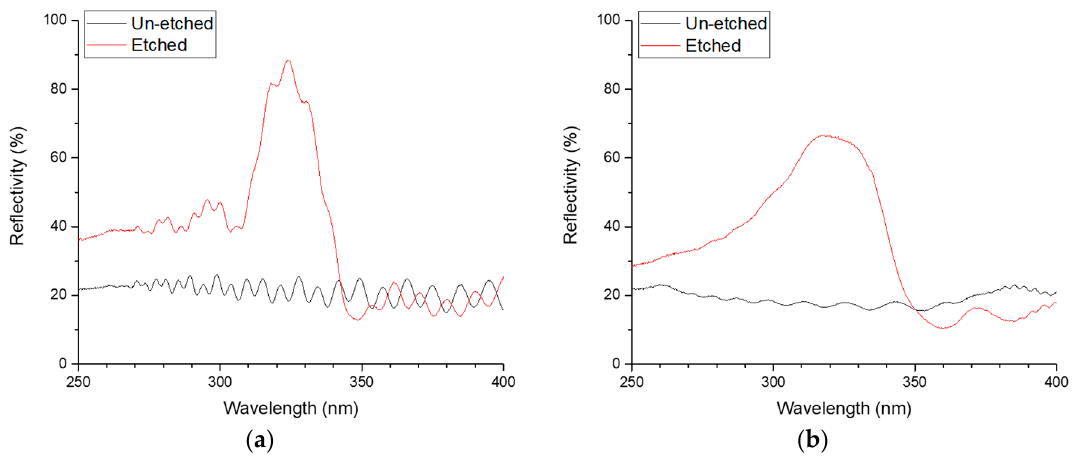
Figure 5. Reflectivity measurements of the two AlGaN DBRs ( a ) sample A and ( b ) sample B.